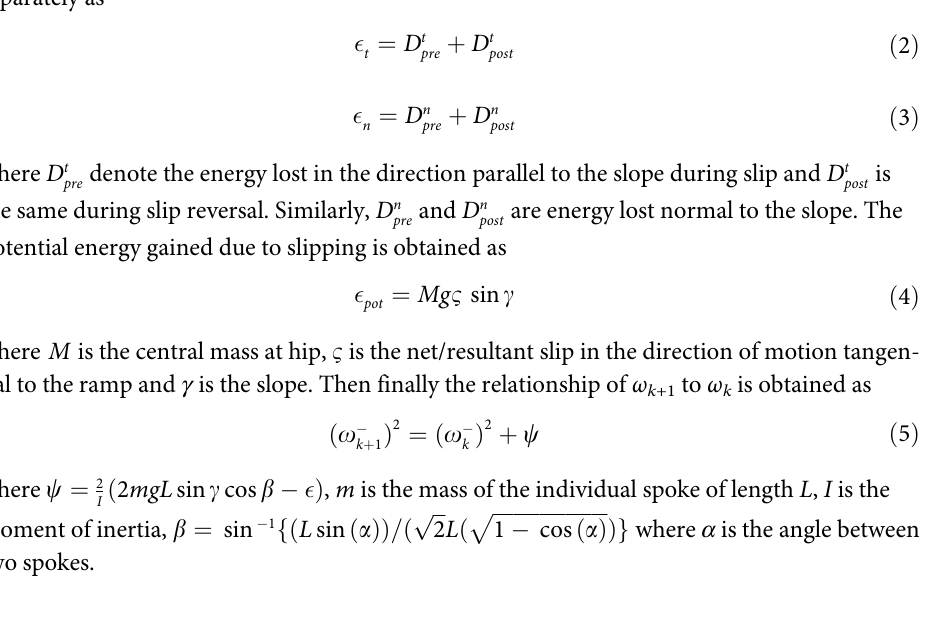
PLOS ONE | https://doi.org/10.1371/journal.pone.0207665 November29,